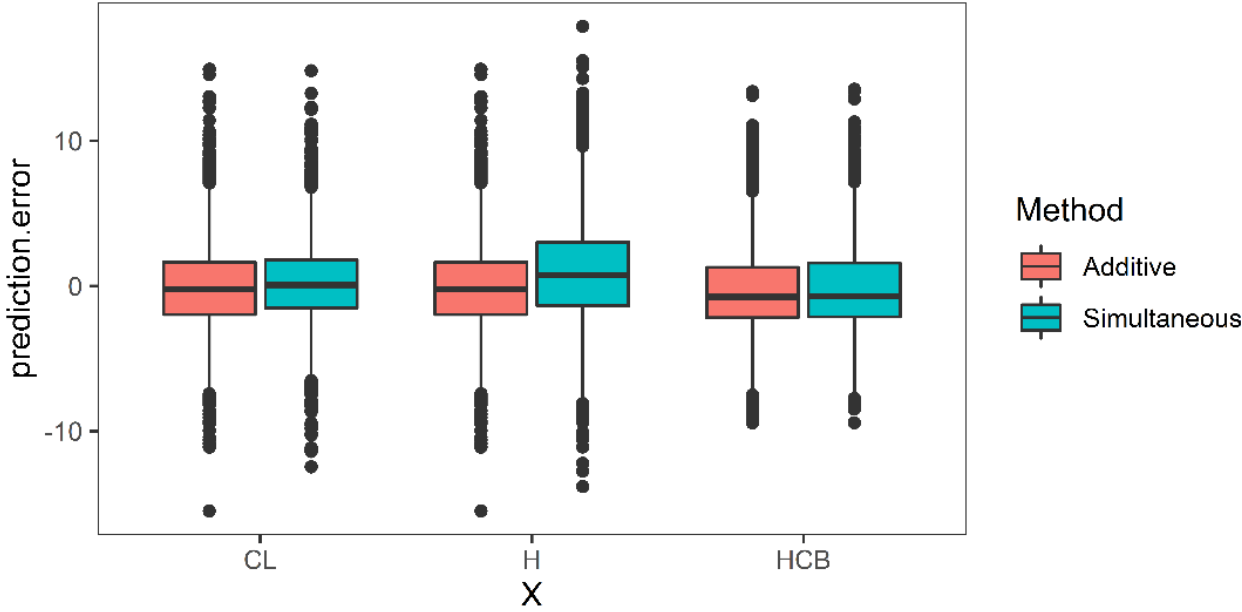
Figure 6. Boxplot of residuals of Equations (19) and (20), fitted by NSUR ( CL : crown length; H : total tree height; HCB : height to live crown base).